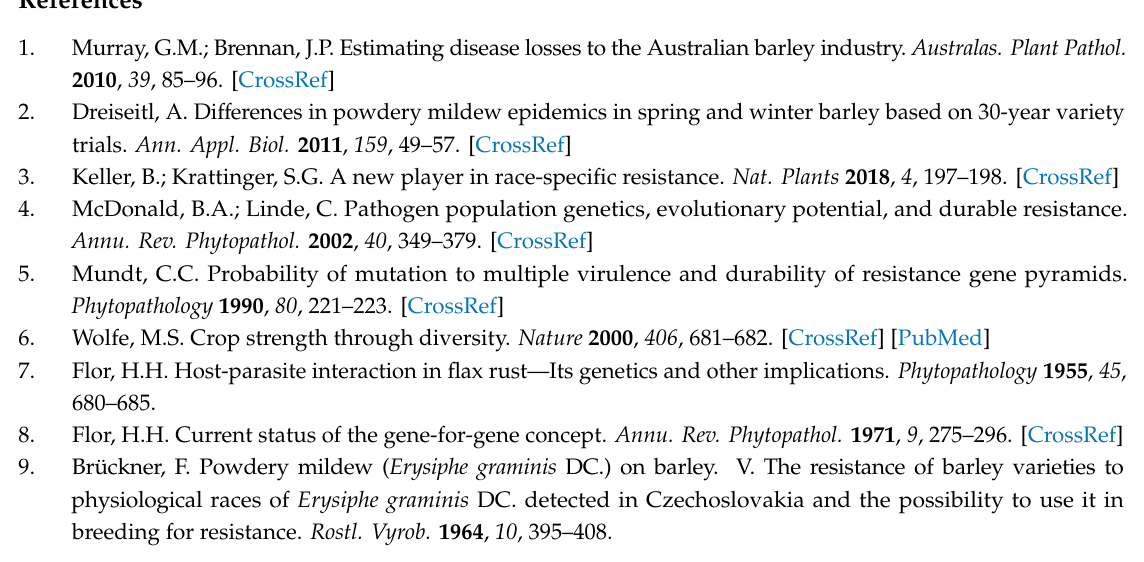
Table S1: Response types developed on leaves of barley after inoculation with an isolate of Blumeria graminis f. sp. hordei